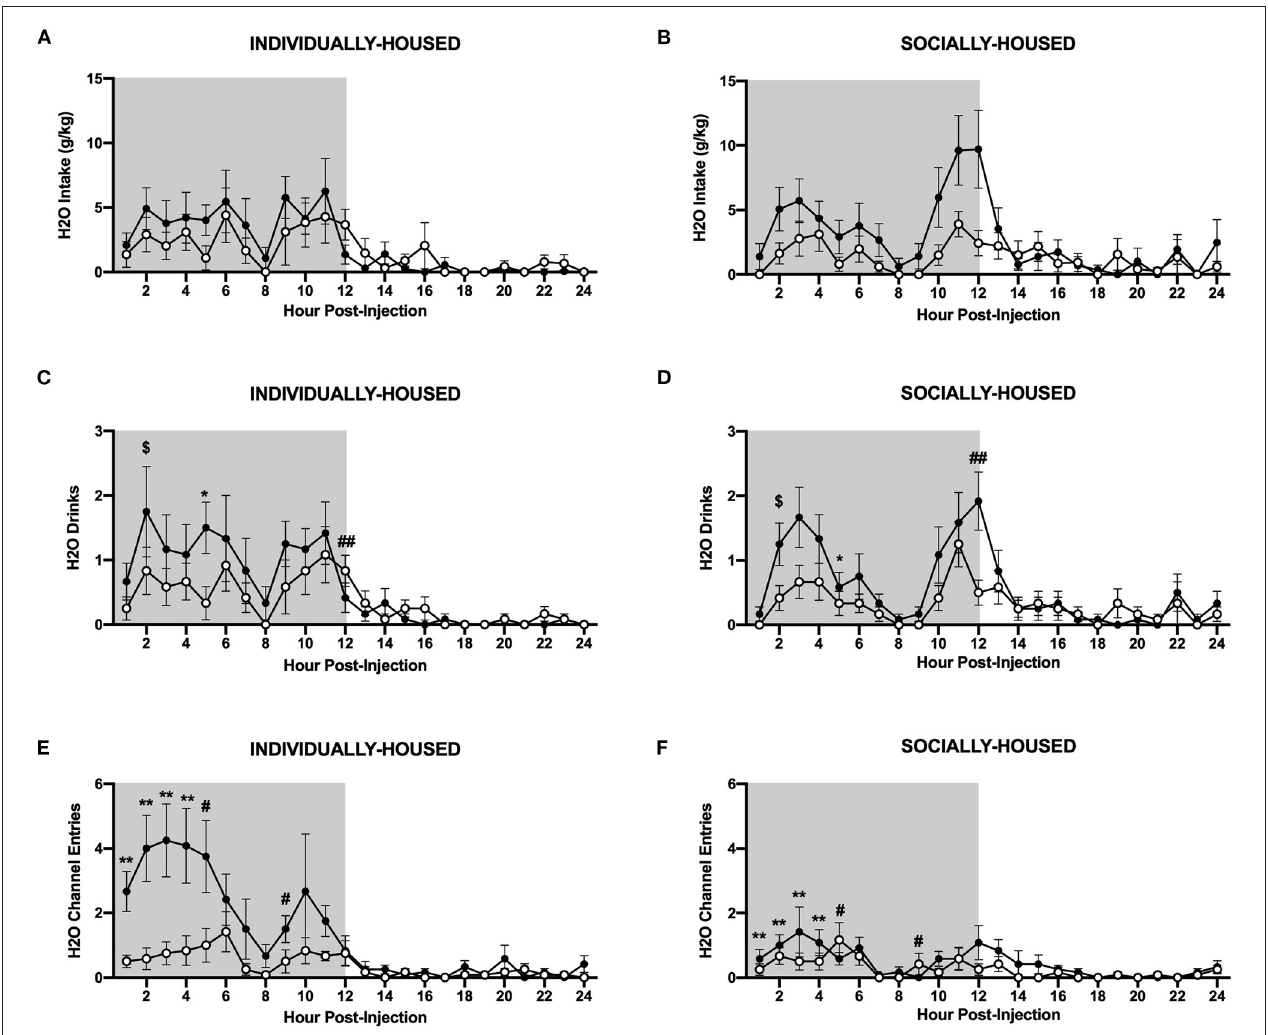
FIGURE 10 | Hourly water data post-CRFR1 antagonism. (A) Water intake in g/kg for individually-housed mice. (B) Water intake in g/kg for socially-housed mice. (C) Number of water drinks for individually-housed mice. (D) Number of water drinks for socially-housed mice. (E) Water channel entries for individually-housed mice. (F) Water channel entries for socially-housed mice. CRFR1 antagonism caused decreases in g/kg water intake and number of water drinks for both socially- and individually-housed mice. This treatment also suppressed non-consummatory channel entries in both groups. $ p = 0.05, * p < 0.05, ** p < 0.01, compared to vehicle-treated mice across housing condition. # p < 0.05 and ## p < 0.01 represent interaction between housing condition and CRFR1 antagonism at specific timepoint. Data represented as mean ± SEM. n = 12/group. Shaded regions are representative of the dark